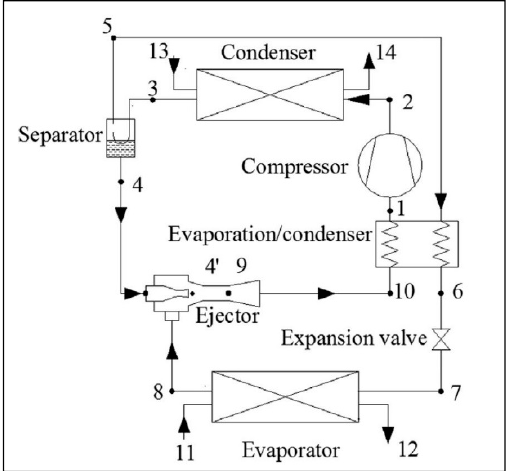
Figure 22. Two-phase ejector auto-cascade refrigeration system [205].